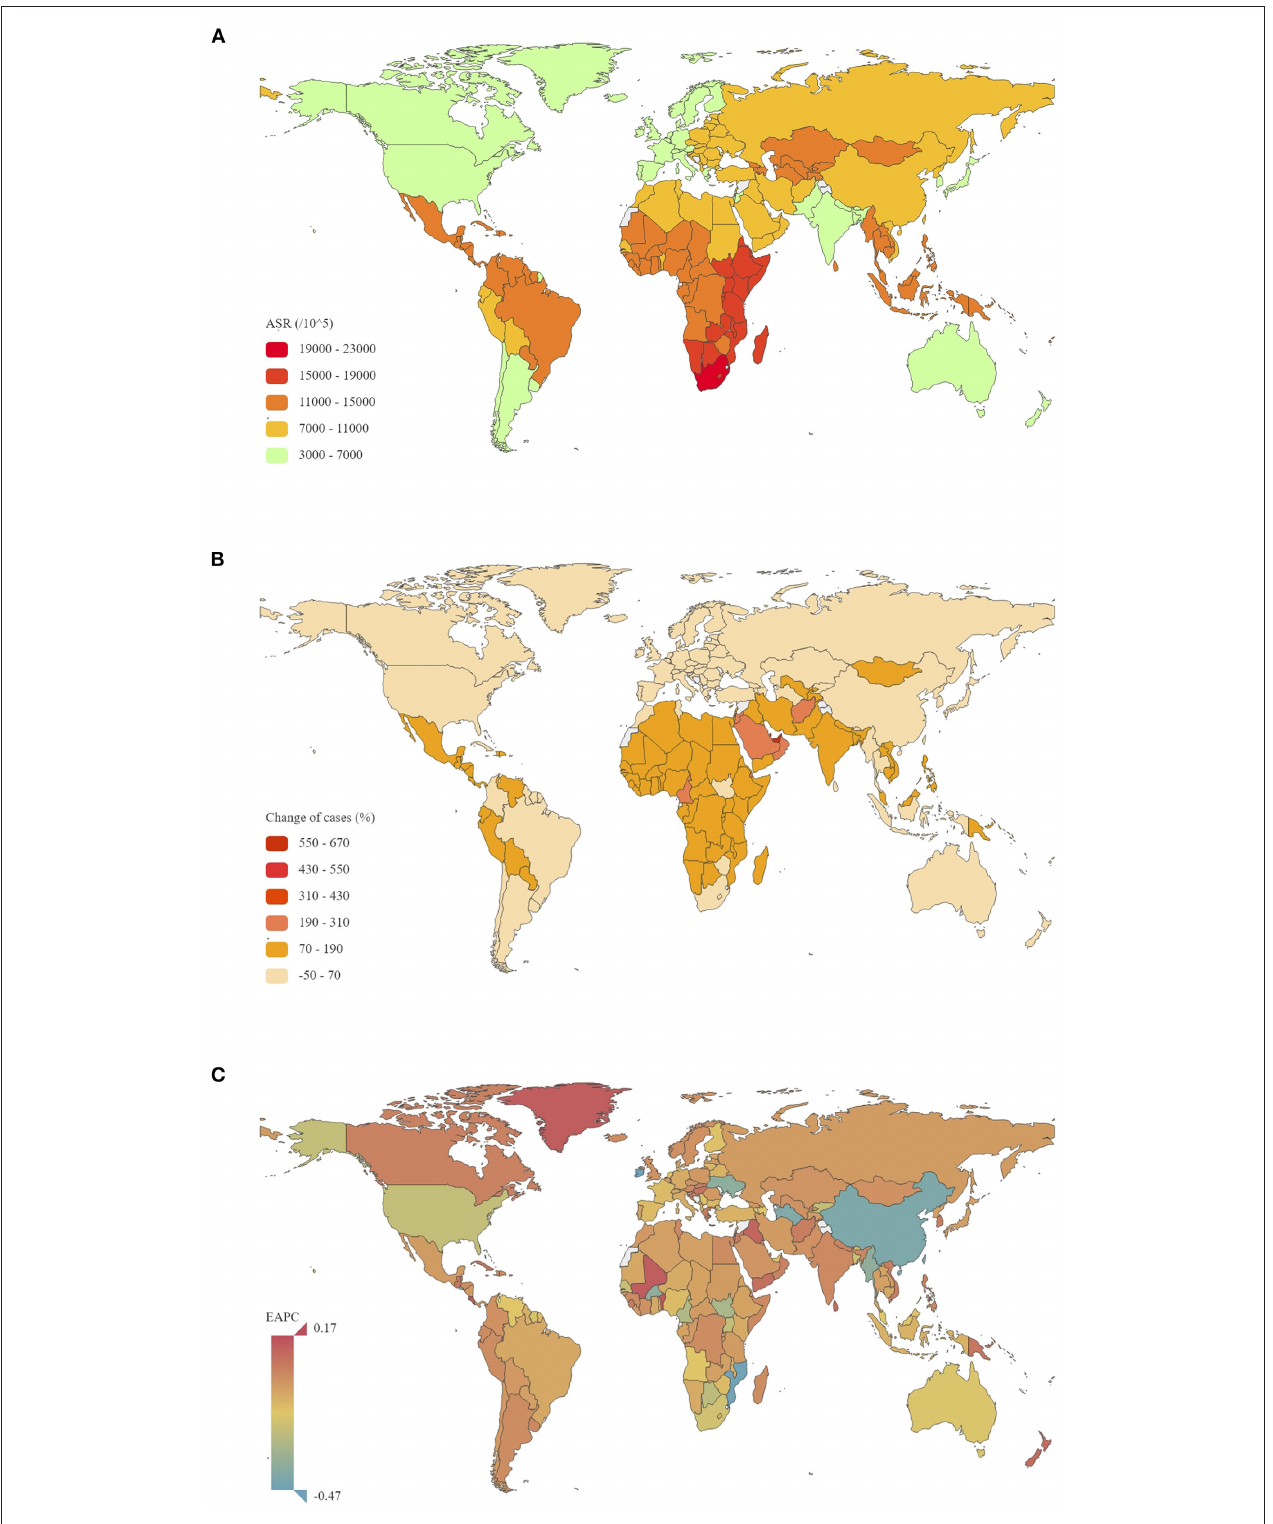
FIGURE 1 | The global disease burden of STIs excluding HIV for men and women in 204 countries and territories. (A) The ASR of STIs excluding HIV in 2019; (B) The relative change in incident cases of STIs excluding HIV between 1990 and 2019; (C) The EAPC in STI ASR from 1990 to 2019 ASR, age-standardized rate; EAPC, estimated annual percentage change; STIs, sexually transmitted infections; HIV, human immunodeficiency virus.